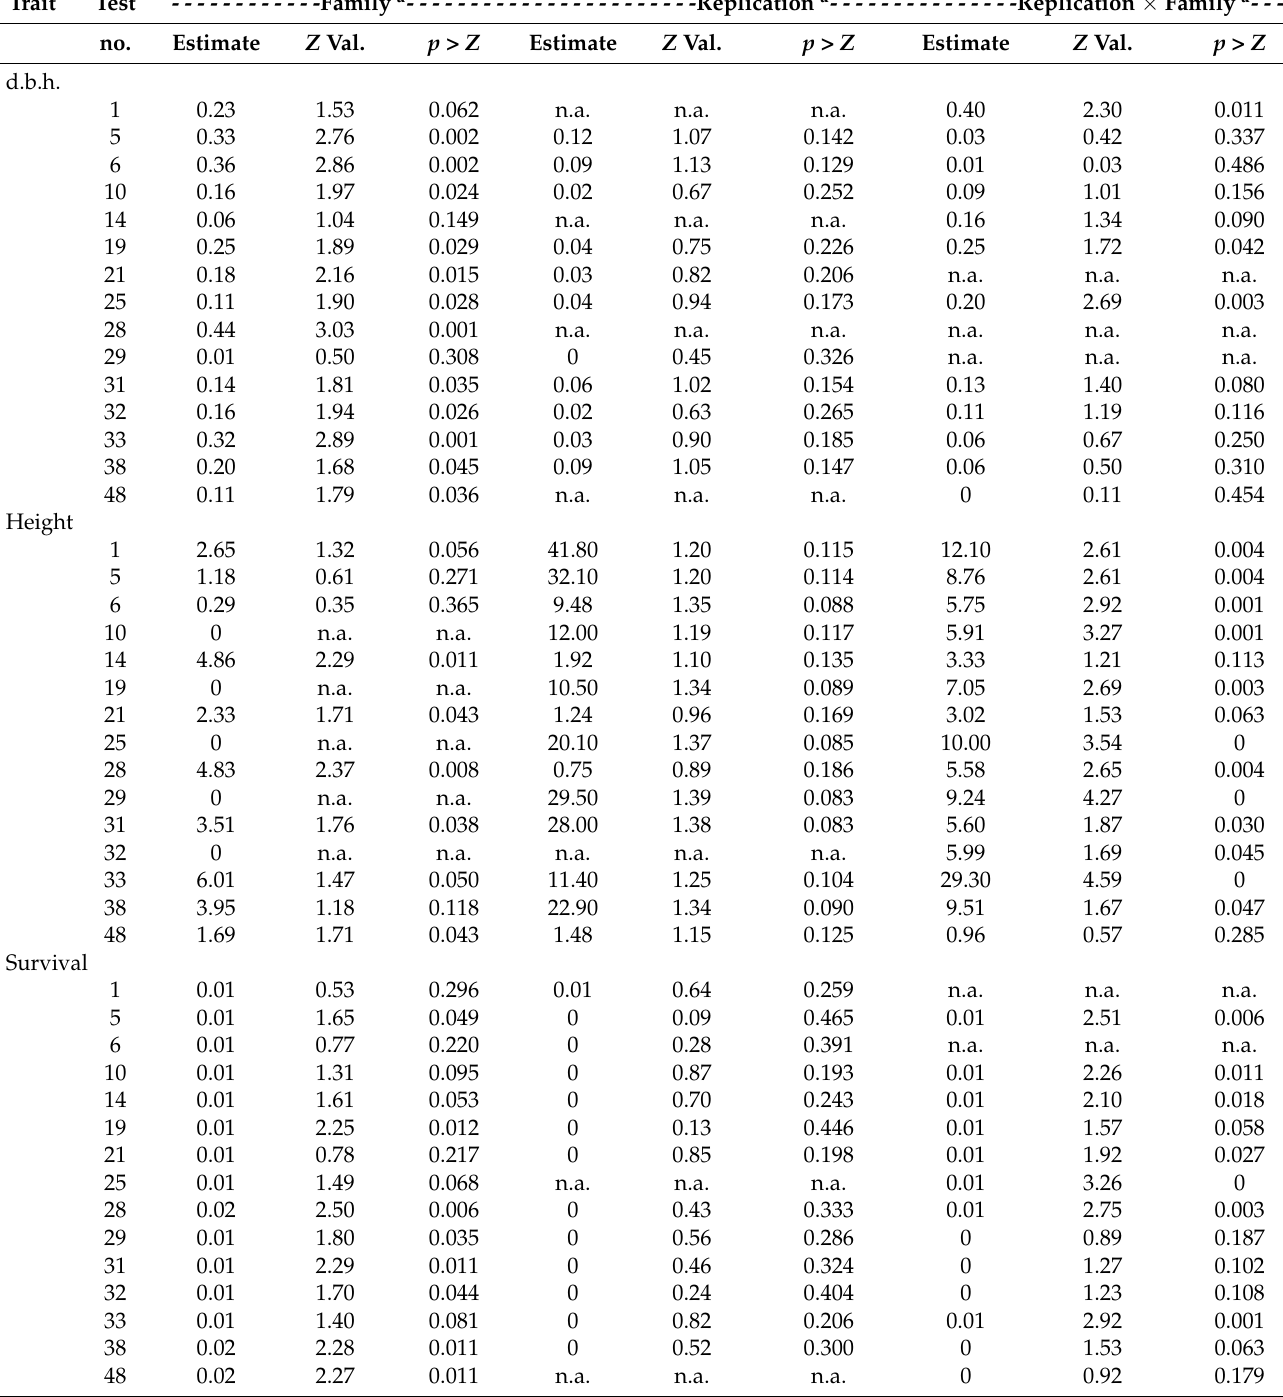
Table 5. Variances of full-sibling family, replication, and replication × family interaction term for d.b.h., tree height, and survival by test